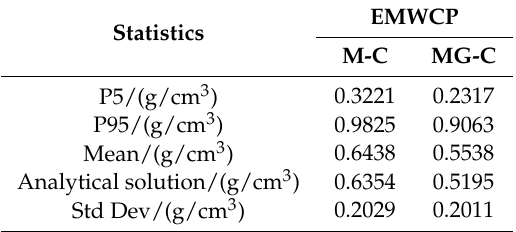
Figure 7. Probability histogram of EMWCP both for M-C and MG-C model. Table 3. The statistics of EMWCP both for M-C and MG-C model.